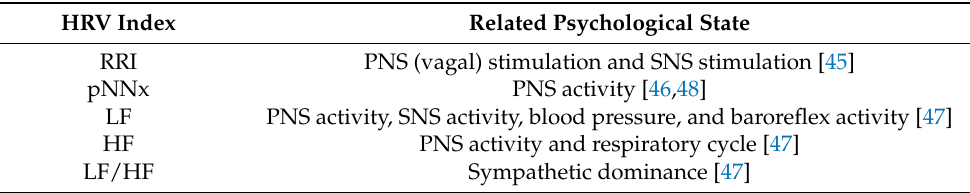
Table 2. HRV indexes used in this study and their related psychological states.